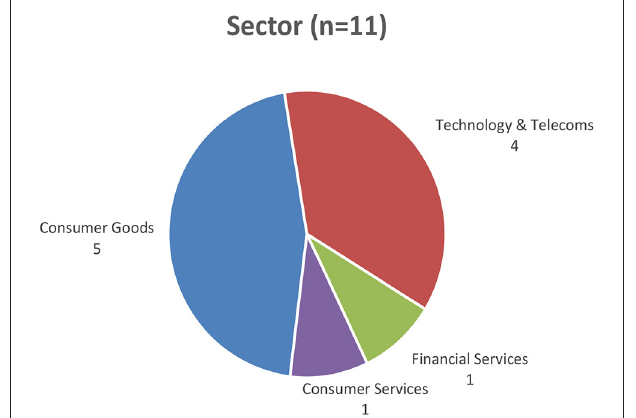
FIGURE 2 | Company sector.